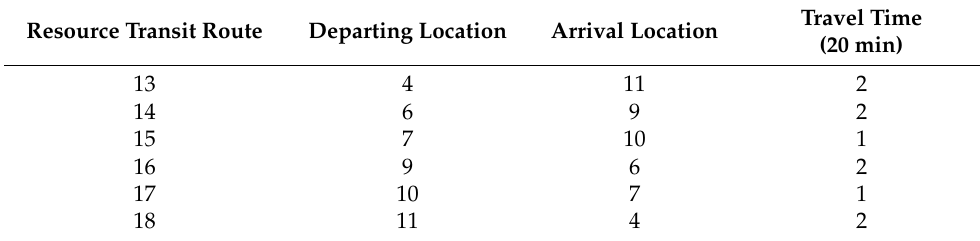
Table 10. New resource transit routes and new travel times after new disaster points occur (Case 2). Resource Transit